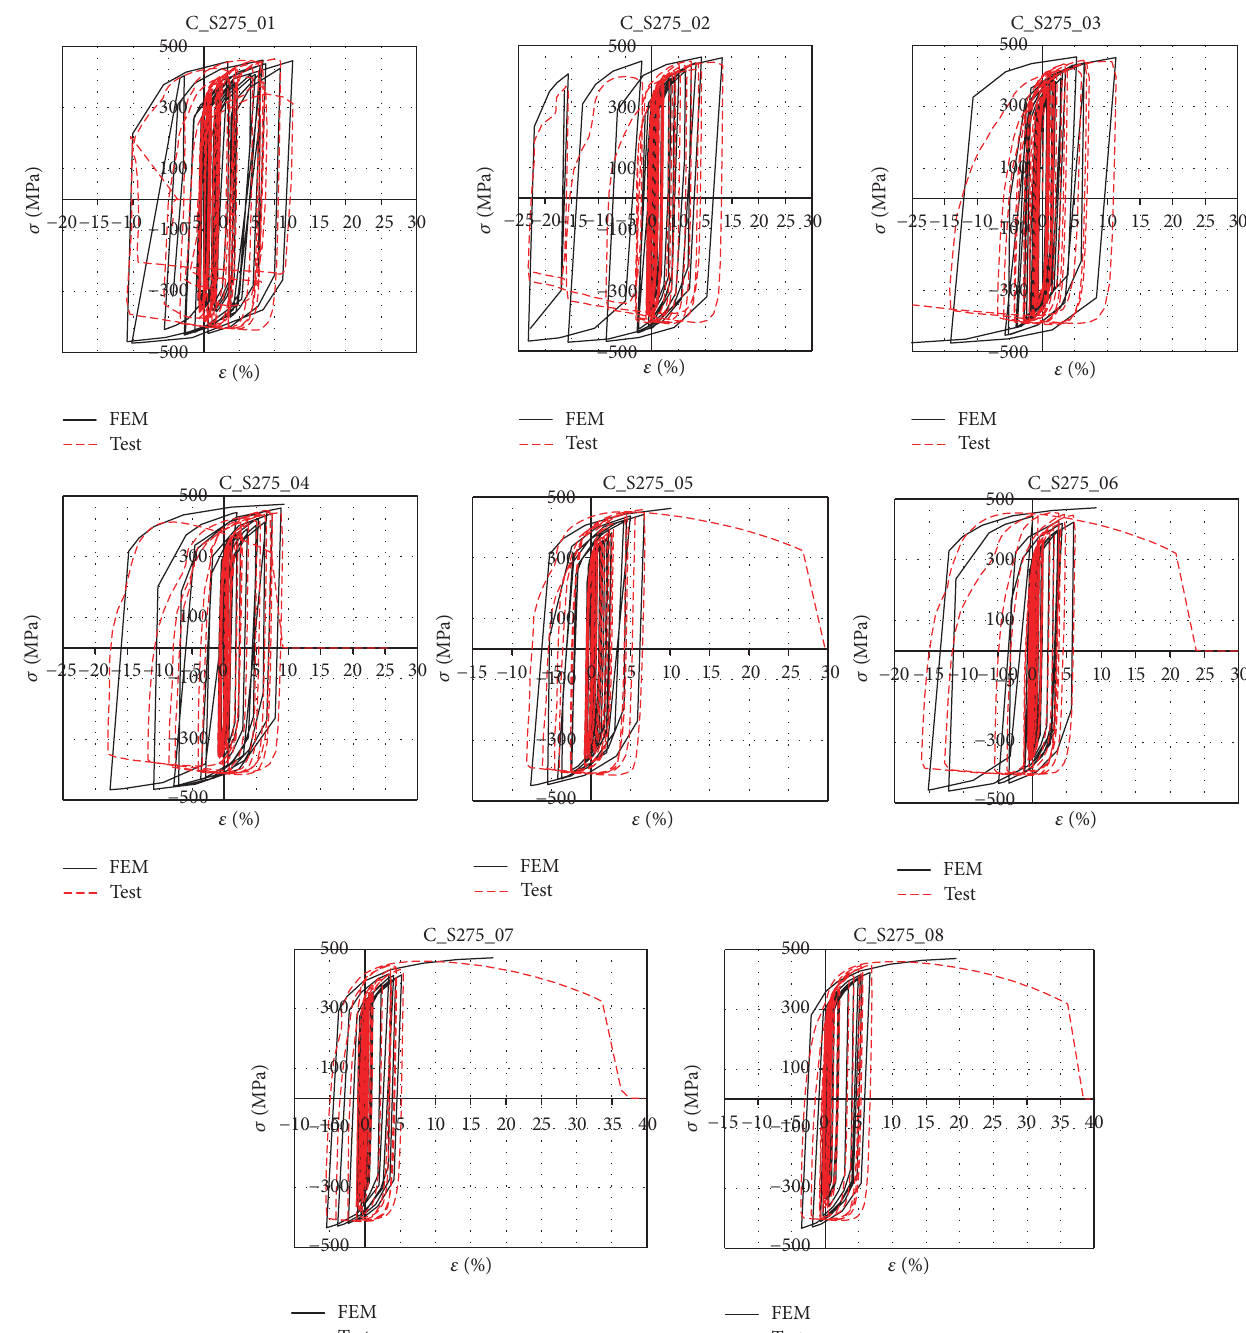
Figure 9: Comparison of the numerical simulation and experimental test for steel S275.